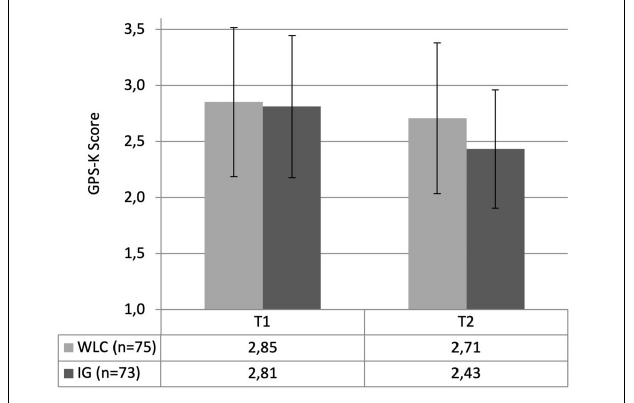
FIGURE 2 | Changes in procrastination scores (GPS-K) from pre- (t1) to post-measurement (t2) in relation to the treatment factor (WLC vs. IG).